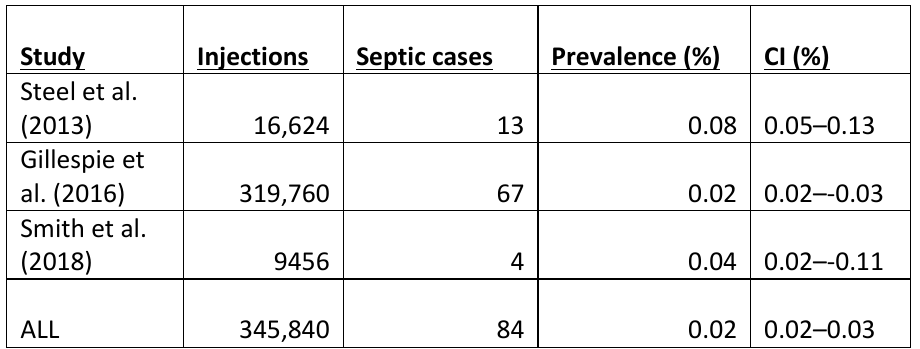
Table 1: Prevalence estimates for synovial sepsis for all intra-articular injections across all studies (as calculated by author of this Knowledge Summary).